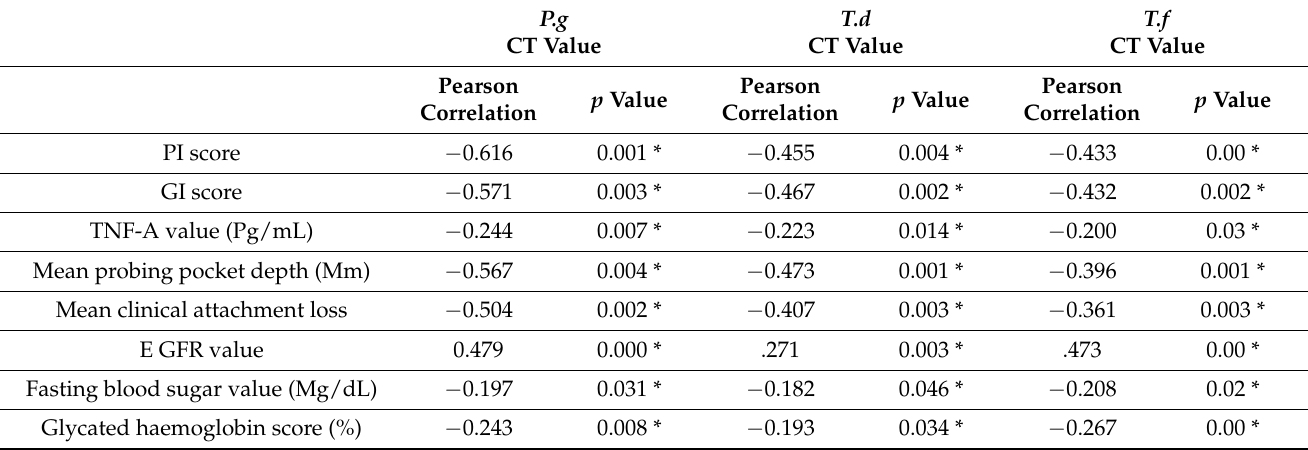
Table 2. Pearson correlation of red complex bacteria with periodontal, diabetic, and renal parameters. P.g CT